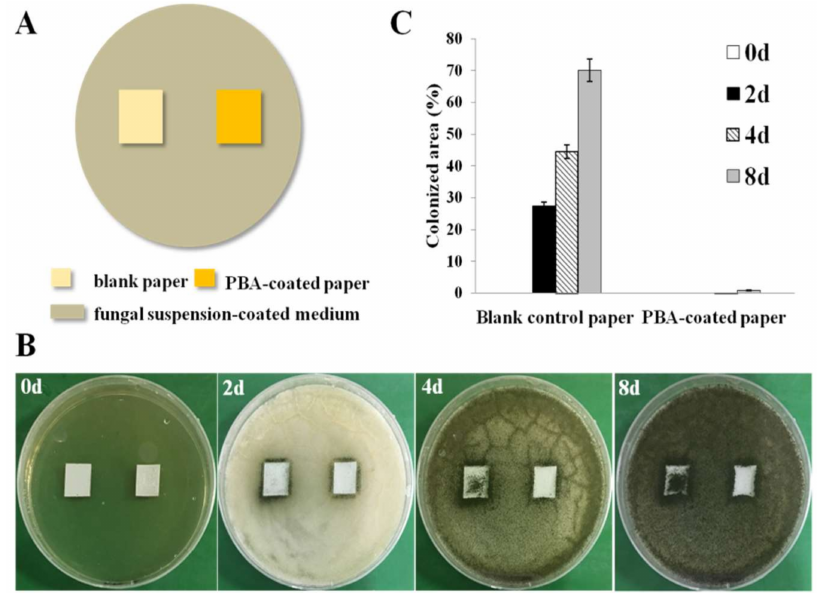
Figure 6. Antifungal evaluation under severe base-fouling conditions. ( A ) Schematic representation of the antifungal model. ( B ) Pictures of the antifungal adhesion effect against A. niger for eight days. ( C ) Fungal average colonized area after 0, 2, 4 and 8 days of incubation.